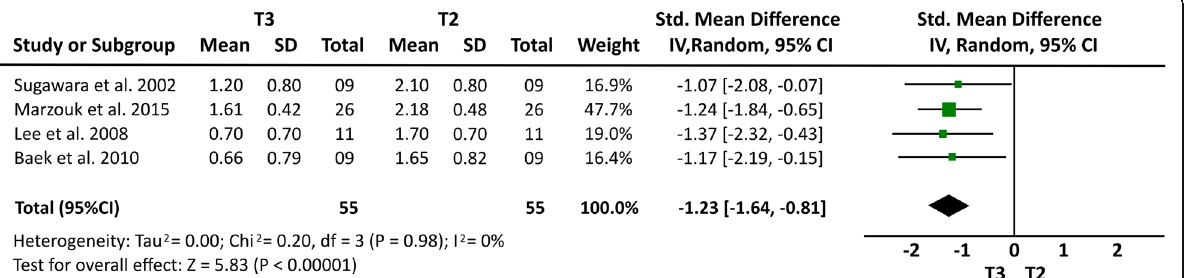
Fig. 2 Forest plot of overbite difference between T2 and T3 in patients who used TADs for molar intrusion after 1-year follow-up. 95% confidence interval and 95% prediction